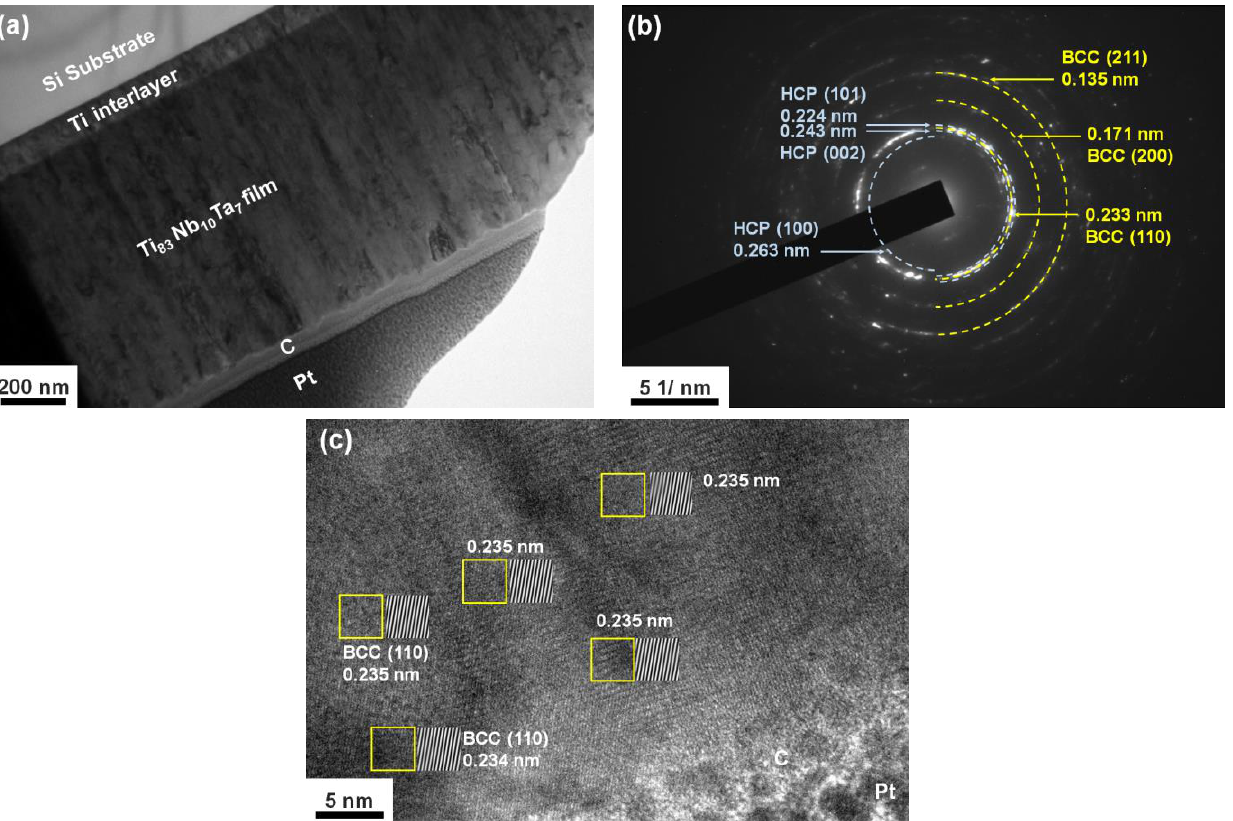
Figure 1. XRD patterns of ( a ) TiNbTa and ( b ) TiNbTaZr films.